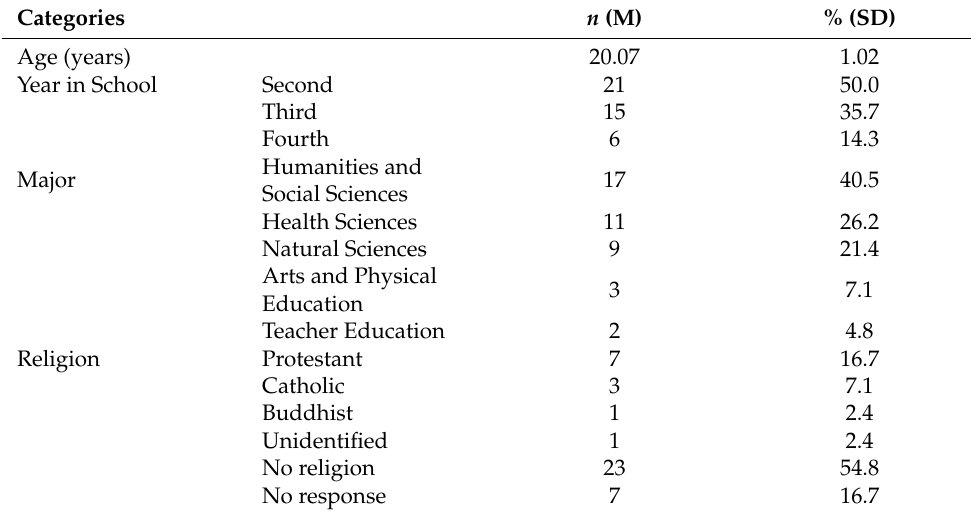
Table 2. General Characteristics of the Participants ( n =